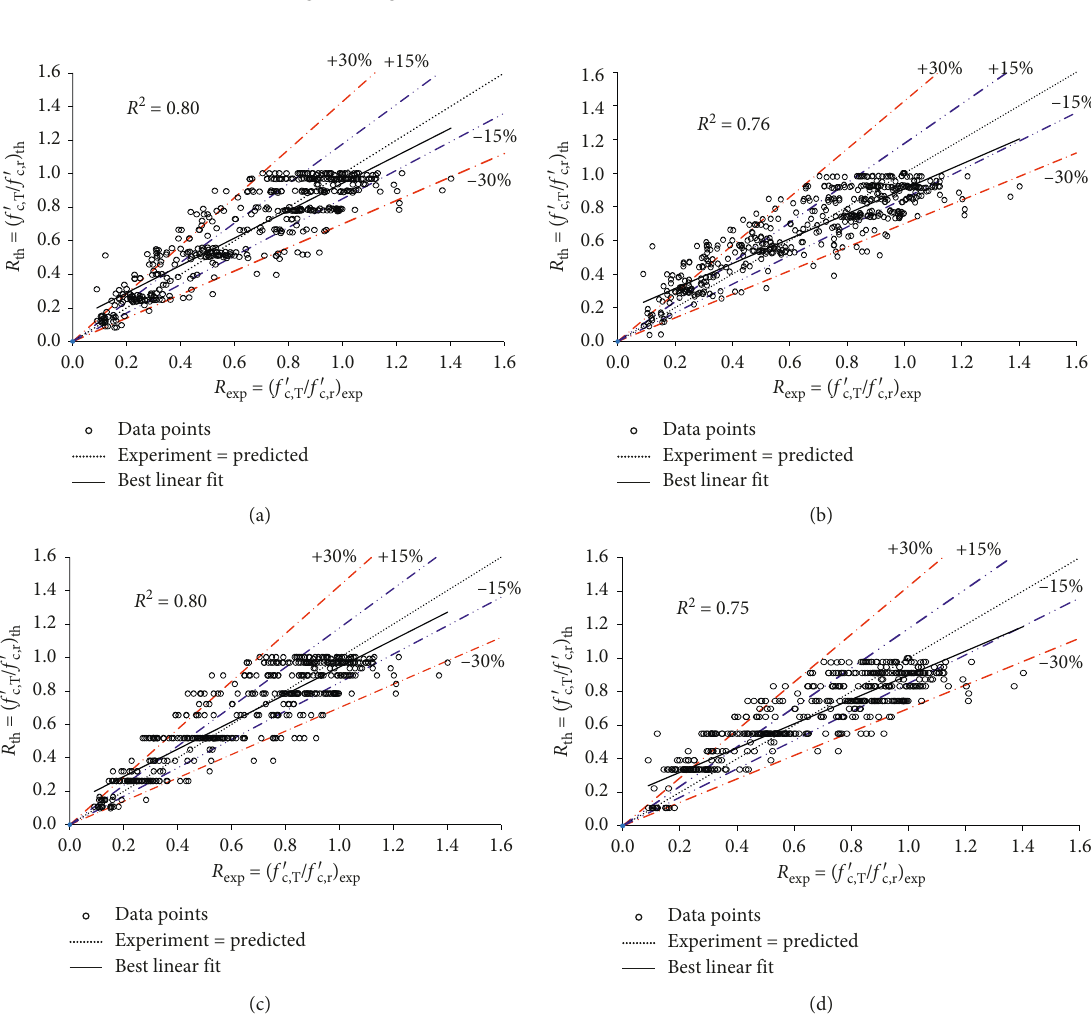
Figure 7: Comparison of normalized strength of HSC predicted by the proposed predictive models with experiment: (a) regression Model 1, (b) regression Model 2, (c) regression Model 3, and (d) regression Model 4.